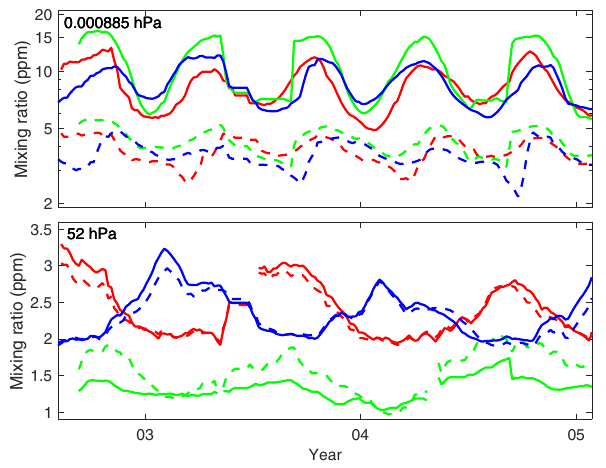
Figure 5. WACCM and GOMOS ozone 5-day time series 1 Au- gust 2002–31 January 2005. Three latitude belts are shown: 50– 30 ◦ S (red lines), 10 ◦ S–10 ◦ N (green) and 30–50 ◦ N (blue). GO- MOS values are shown by solid lines, WACCM by dashed lines. The 5-day time series are smoothed by a moving average of 45 days. Note that in the top panel the y axis is logarithmic.